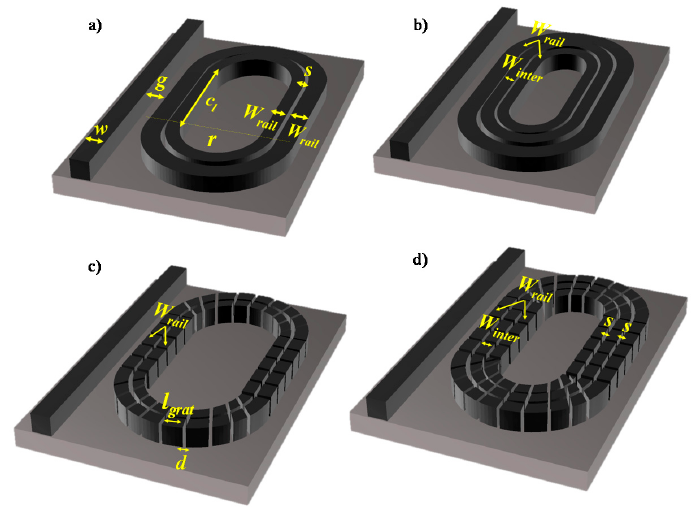
Figure 5. Variation of ( a ) Γ slot + Γ gap , ( b ) Γ c , ( c ) Transmission (dB), on the WG width ( W rail ).